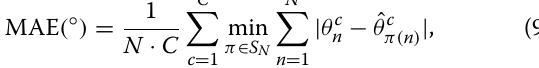
different DOAs in the range (cid:2) = { 0, 5, . . . , 180 } . The sam- pling rate of all signals and RIRs was set to 16 KHz. The speakers were positioned on a radius of r = 1.5 m from the center of the microphone array. To enrich the train- ing diversity, the radius of the speakers was perturbed by a Gaussian noise with a variance of 0.1 m. The DOA of each